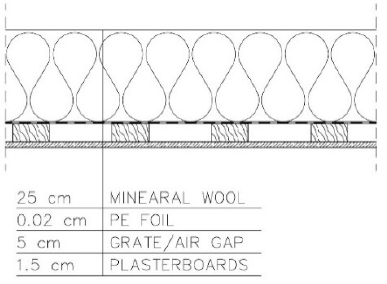
Figure 4. Variant 2: PE foil above the grate for fixing plasterboards. Roof ventilation equal to 20 changes per hour. − Variant 3—PE foil under the grate for fixing plasterboards. Mineral wool fills the air gap formed by the grate. Roof ventilation equal to 20 changes per hour (Figure 5).